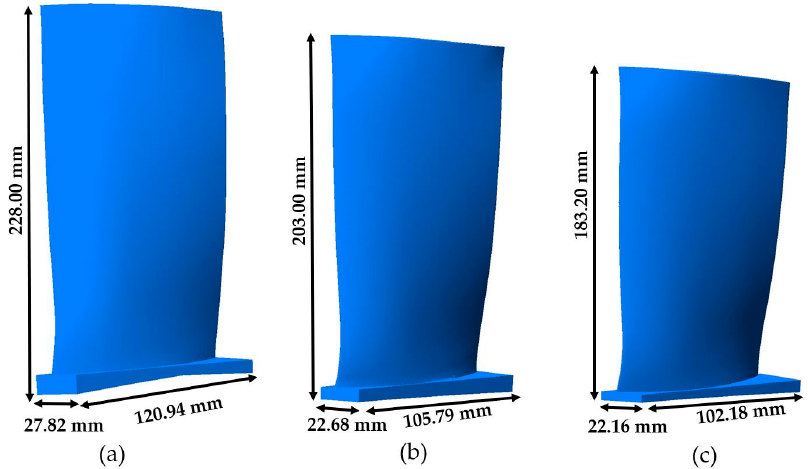
Figure 3. The geometric dimensions of the blades at: ( a ) Stage 6, ( b ) Stage 7, and ( c ) Stage 8.